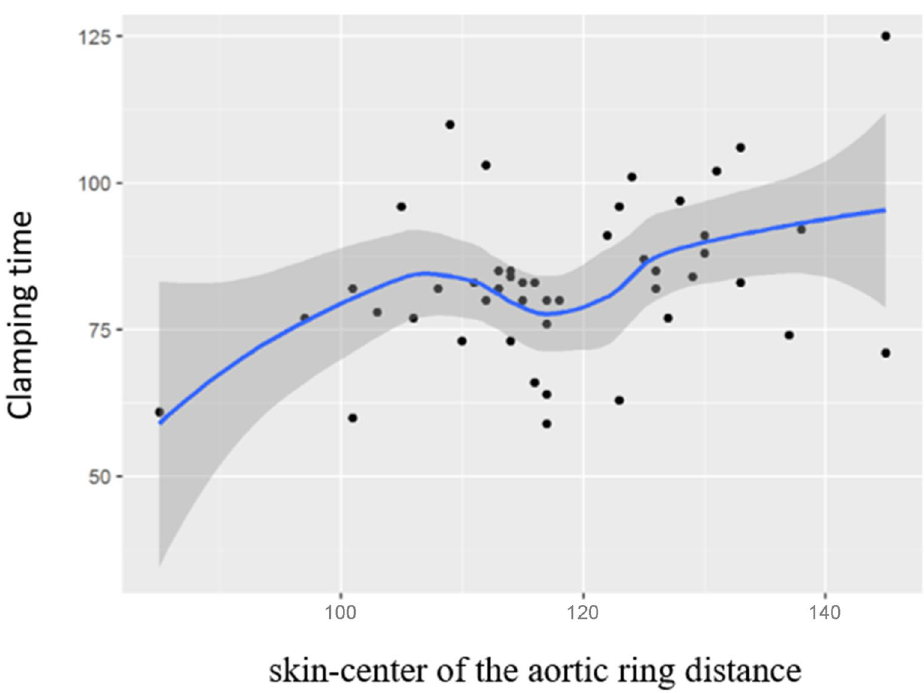
Figure 3. Correlation between clamping time and skin-center of the aortic ring